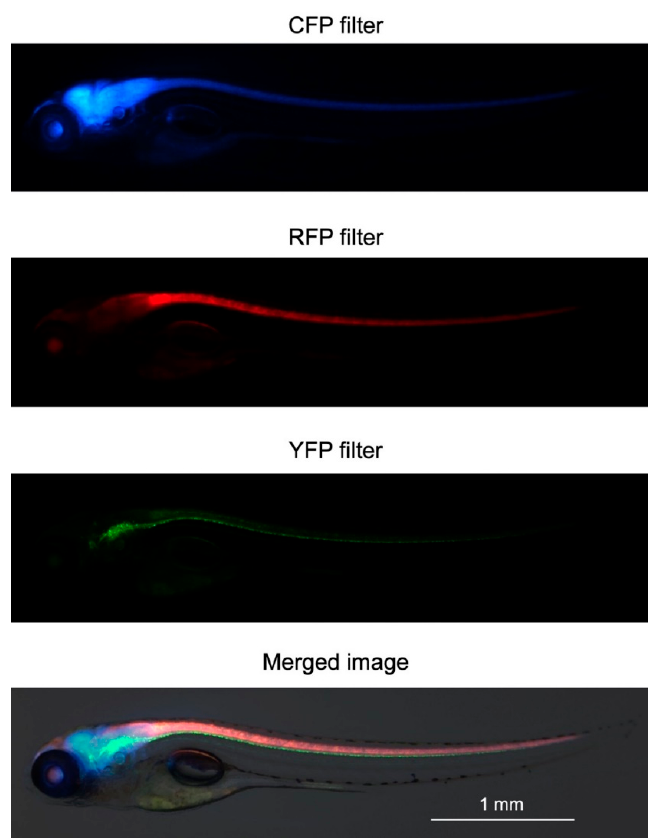
Figure 2. In vivo fluorescence imaging of the triple-Tg zebrafish line.